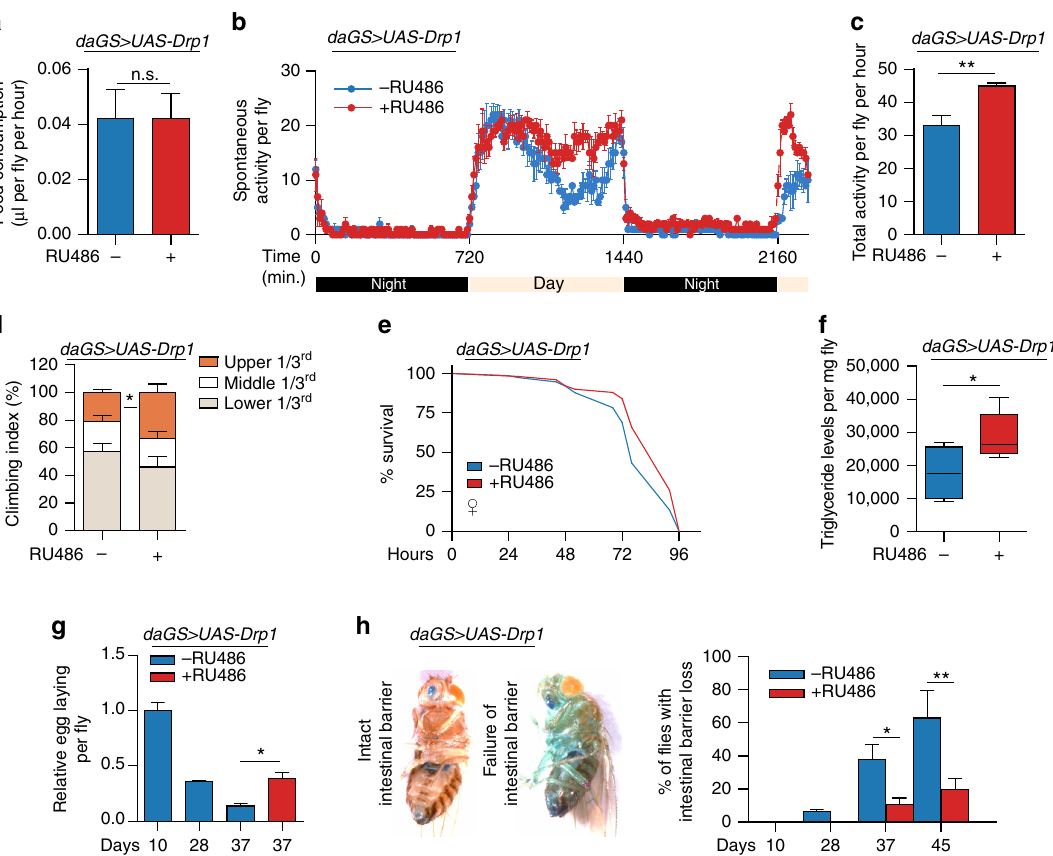
Fig. 2 Midlife Drp1 induction delays age-onset pathology and prolongs healthspan. a Capillary feeding assay (CAFE) of 37 day old daGS > UAS-Drp1 females with or without RU486-mediated transgene induction from day 30 to day 37. n = 8 vials of 10 fl ies per condition; p > 0.05 and is non-signi fi cant (n.s.); two-tailed unpaired t -test. b , c Spontaneous physical activity b of 37 day old daGS > UAS-Drp1 females with or without RU486-mediated transgene induction from day 30 to day 37. Quanti fi cation of total activity per fl y per hour c from spontaneous activity graphs. n = 3 vials of 10 fl ies per condition; ** p < 0.01; two-tailed unpaired t -test. d Climbing index as a measure of endurance of 37 day old daGS > UAS-Drp1 females with or without RU486- mediated transgene induction from day 30 to day 37. n = 90 fl ies per condition; ∗ p < 0.05; two-tailed Mann – Whitney test. e Survival curves without food of 37 day old daGS > UAS-Drp1 females with or without RU486-mediated transgene induction from day 30 to day 37. p < 0.01; log-rank test; n = 100 fl